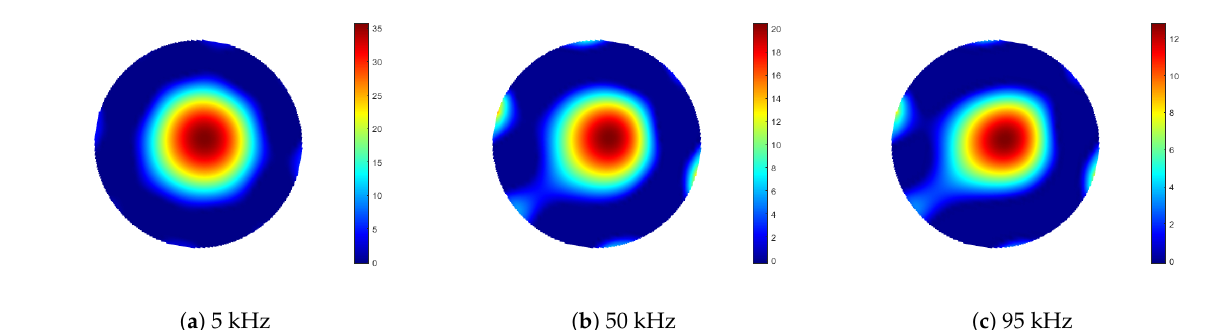
Figure 13. Reconstructed image of aluminium rod partially encapsulated in a copper shroud, with shroud frame data subtracted ( ∆ V = V both − V shrd ), leaving the rod; acquired using 5, 50 and 95 kHz excitation field frequencies. Image ( a ) clearly shows the aluminium rod, while the influence of the shroud at higher frequencies is apparent in ( b , c ), where the rod is weaker and distorted.